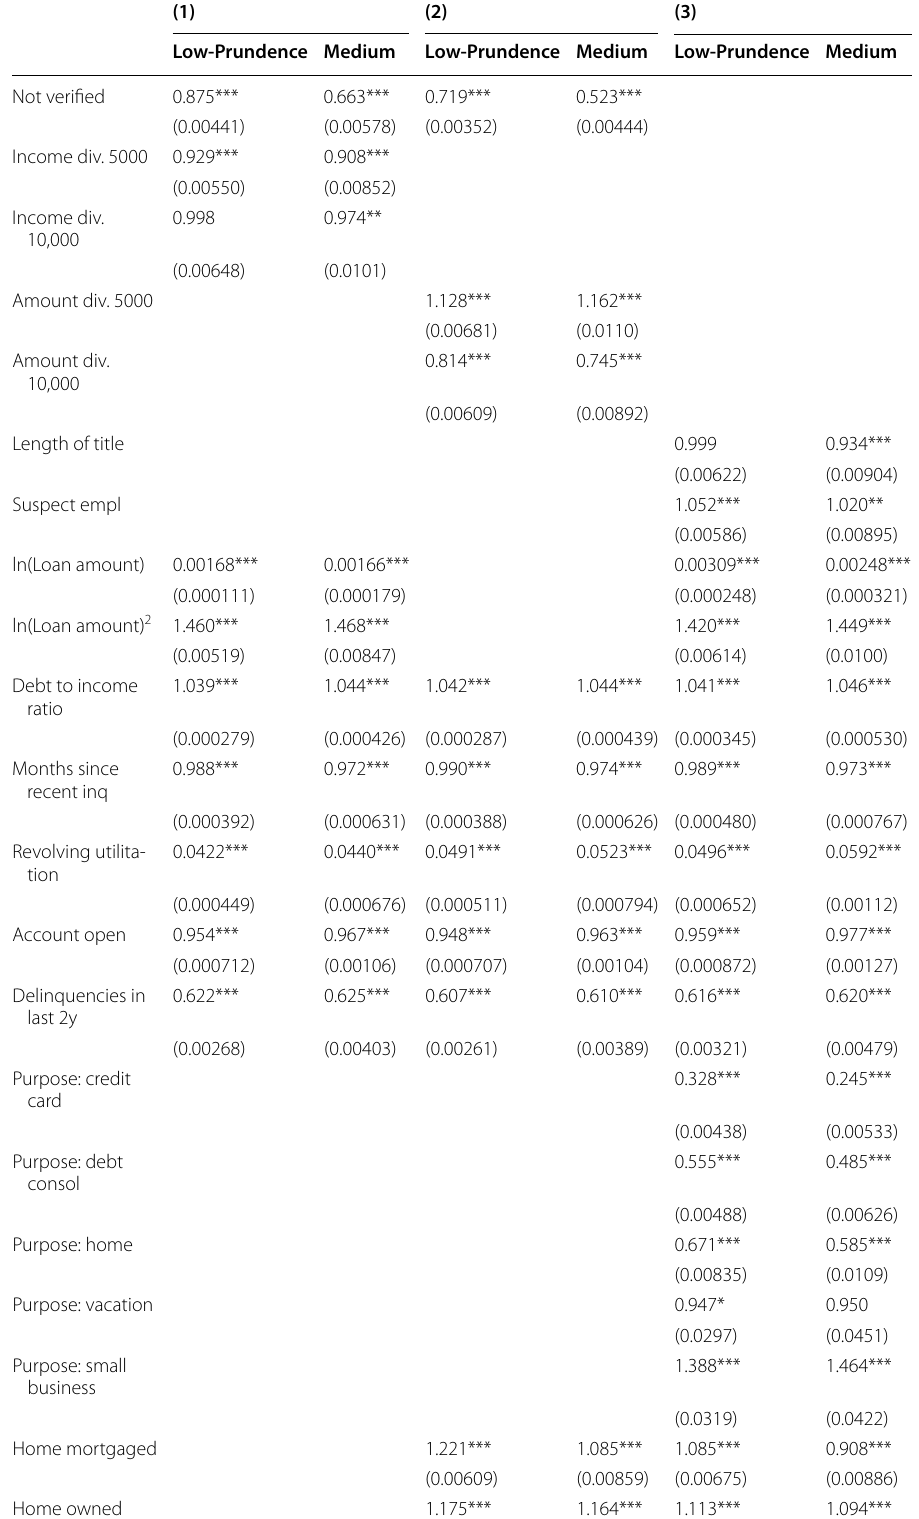
Table 5 Regression results with the dependent variable Prudence grade (1) (2) (3) Low-Prundence Medium Low-Prundence Medium Low-Prundence